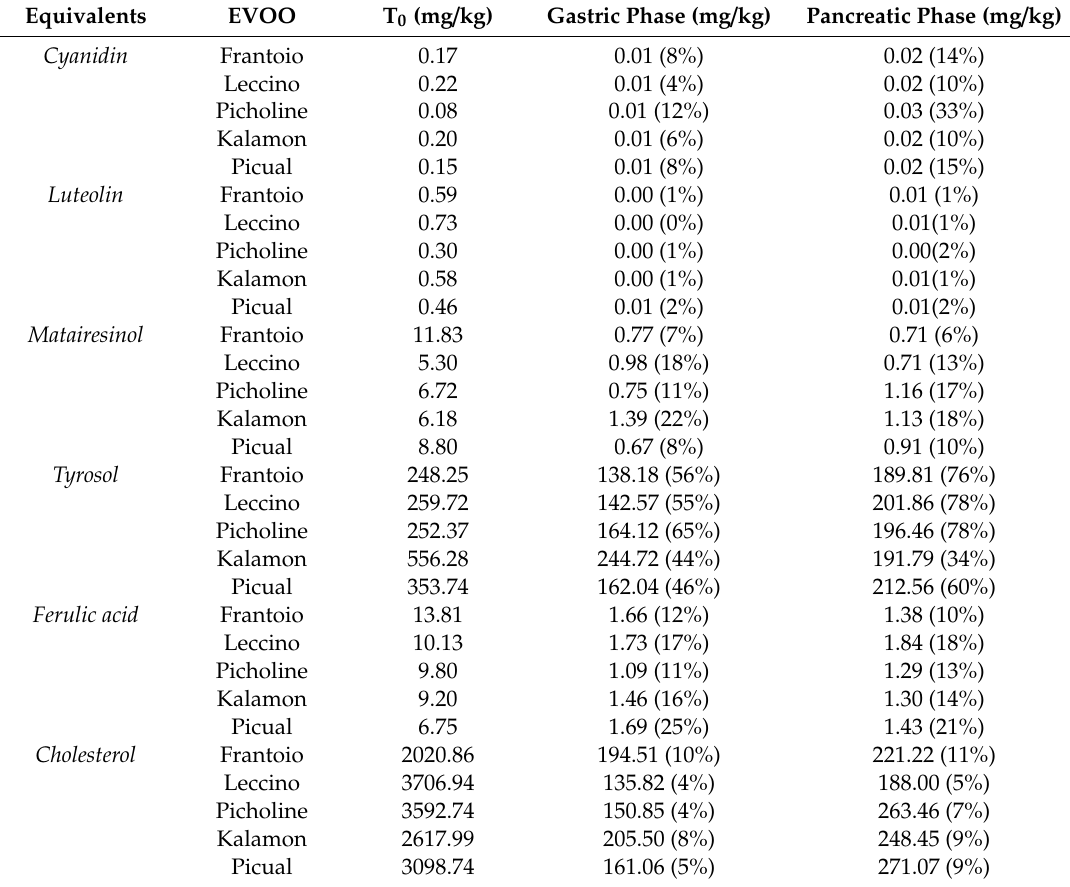
Table 2. Semi-quantitative contents of polyphenols and sterols (expressed as mean value, n = 3) in EVOO samples prior to the in vitro digestion (T 0 ), together with their changes during in vitro gastrointestinal digestion, considering both gastric and pancreatic phases. The % bioaccessibility value for each digestion phase is reported in round